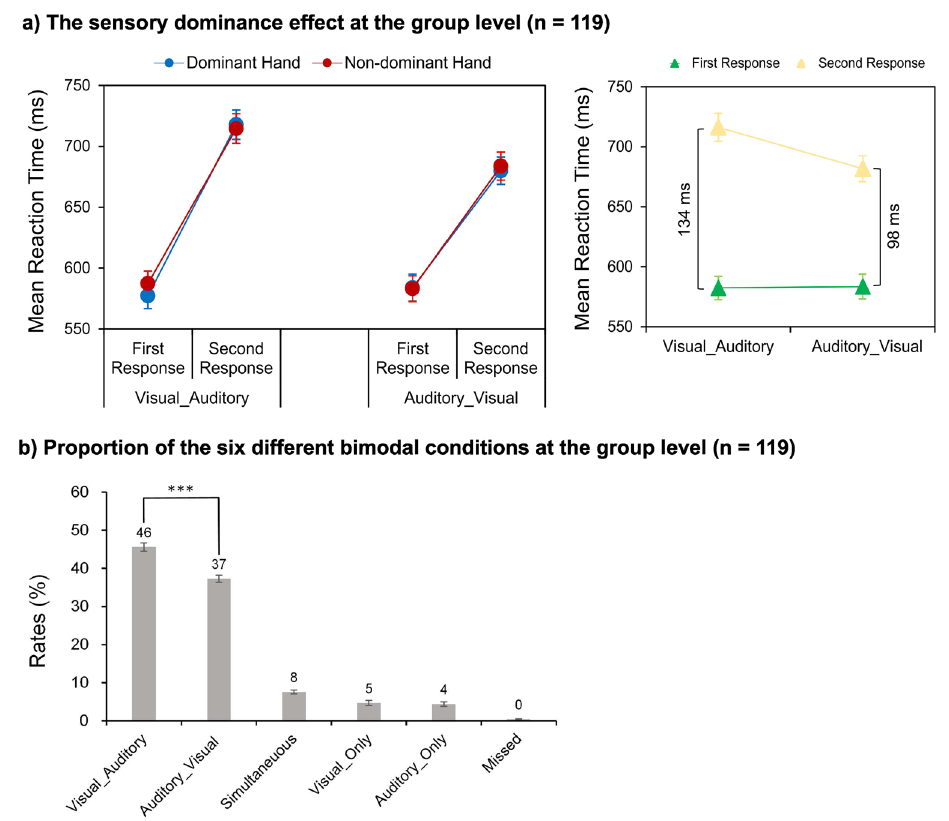
Figure 2. Robust visual dominance effects in the bimodal trials at the group level, n = 119. ( a ) Left panel, Mean RTs of the visual and the auditory components of the bimodal trials are shown as a function of the sensory dominance (VA vs. AV trials), the response order (first vs. second response), and the response hand (dominant vs. non-dominant hand). Right panel, The simple effects of the size of sensory dominance effect for the significant sensory dominance*response order interaction. ( b ) Proportion of the six different types of conditions in the bimodal trials. *** p < 0.001, ** p < 0.01, * p < 0.05. The error bars show standard errors